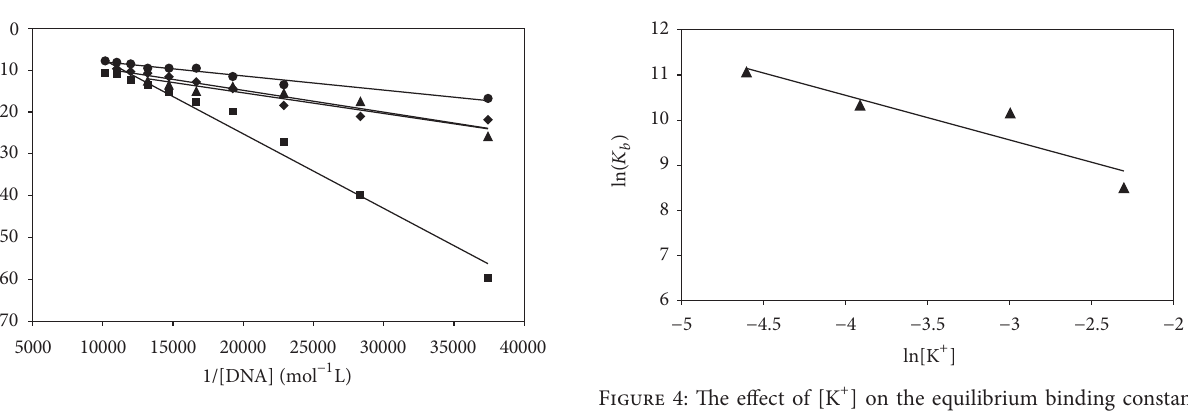
versus 1/[ds-DNA] for the ) based on 𝐴𝐴 0 /(𝐴𝐴 𝐴 𝐴𝐴 0 ) 𝐾𝐾 𝑏𝑏